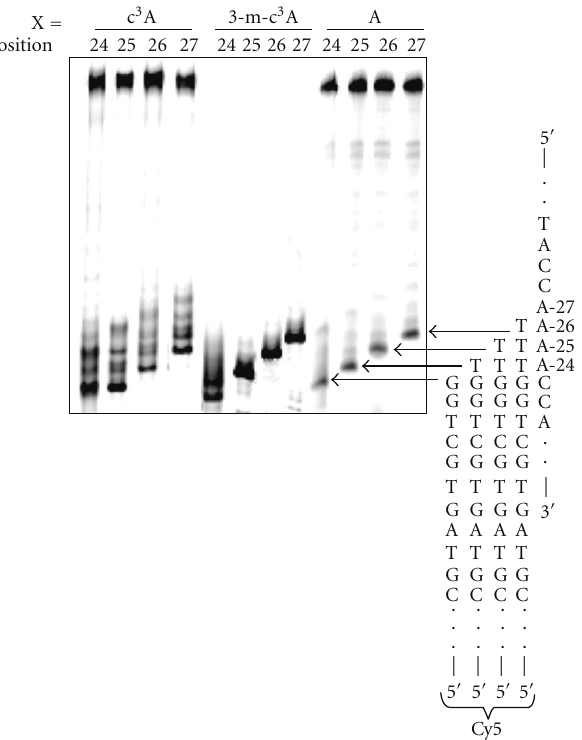
Figure 7: The e ff ect of the position of the c 3 A and 3-m-c 3 A lesions within the A 4 tract on the insertion by T7 Sequenase opposite the modification using 10 or 100 μ M of the dNTPs. The location of the modification is denoted by the numbering system in Scheme 1. The primers (Table 1, P23, P24, P25 and P26) stop 1nt before the position of the c 3 A or 3-m-c 3 A